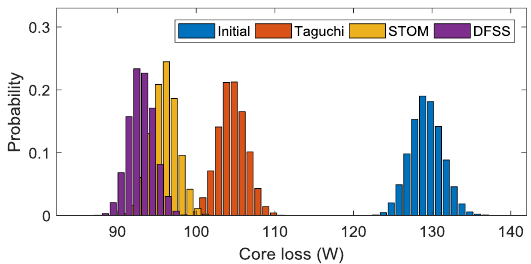
Figure 15. Distributions of core loss considering the manufacturing tolerances.